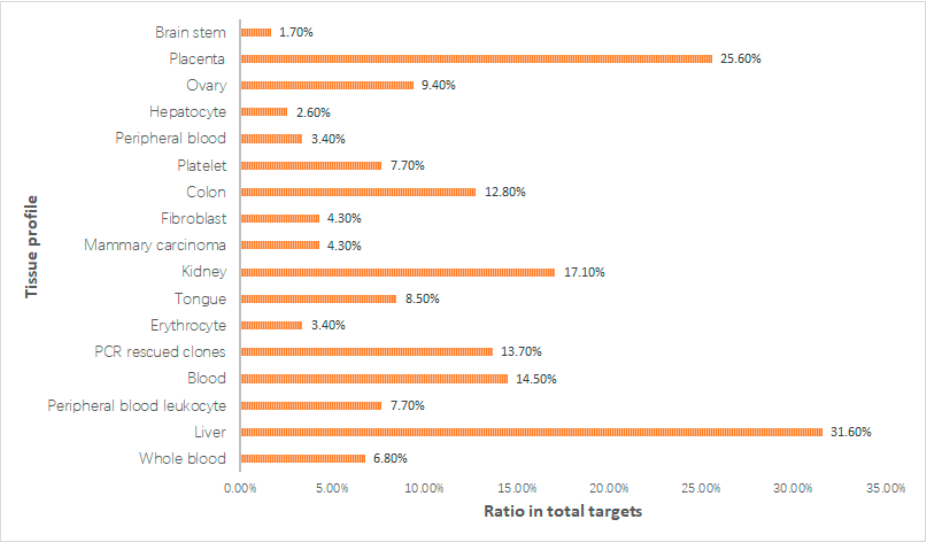
Figure 3. The target tissue distribution based on tissue expression Figure 4. The target tissue distribution based on tissue expression profile.